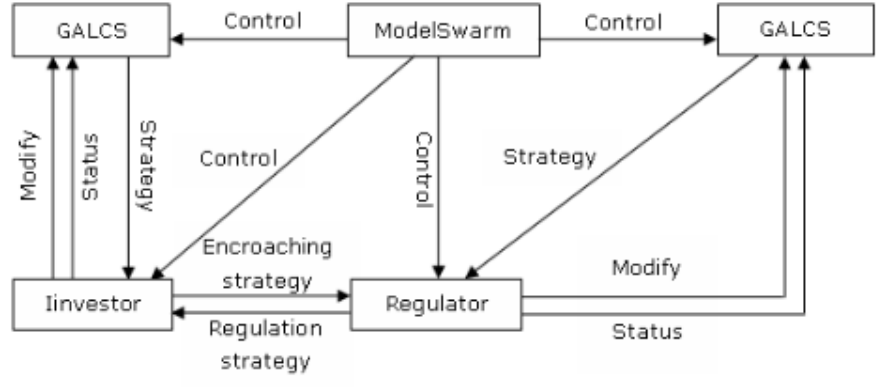
Figure 2. The environment of the simulation